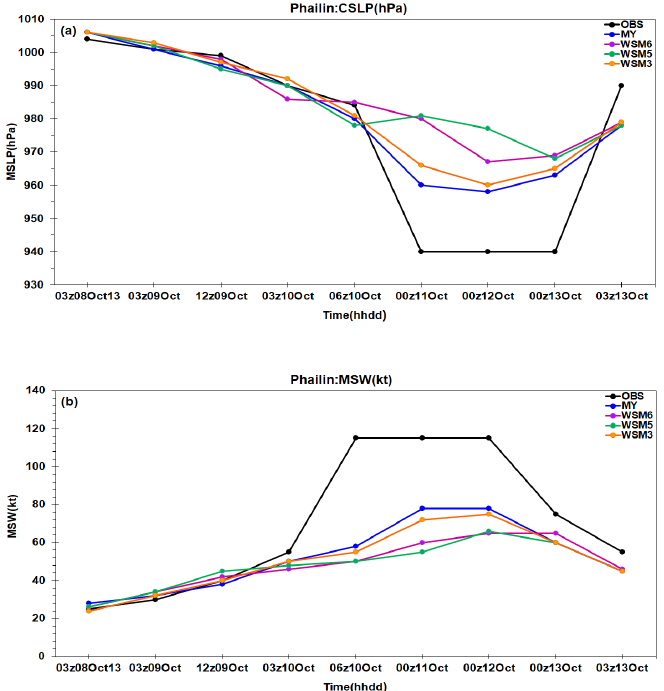
Figure 4. Simulated track errors from the 12 h average derived from different WRF experiments at ( a ) D01 and ( b ) D02 resolutions. The bar and scheme are in the sequence of MY, WSM6, WSM5, and WSM3 respectively.